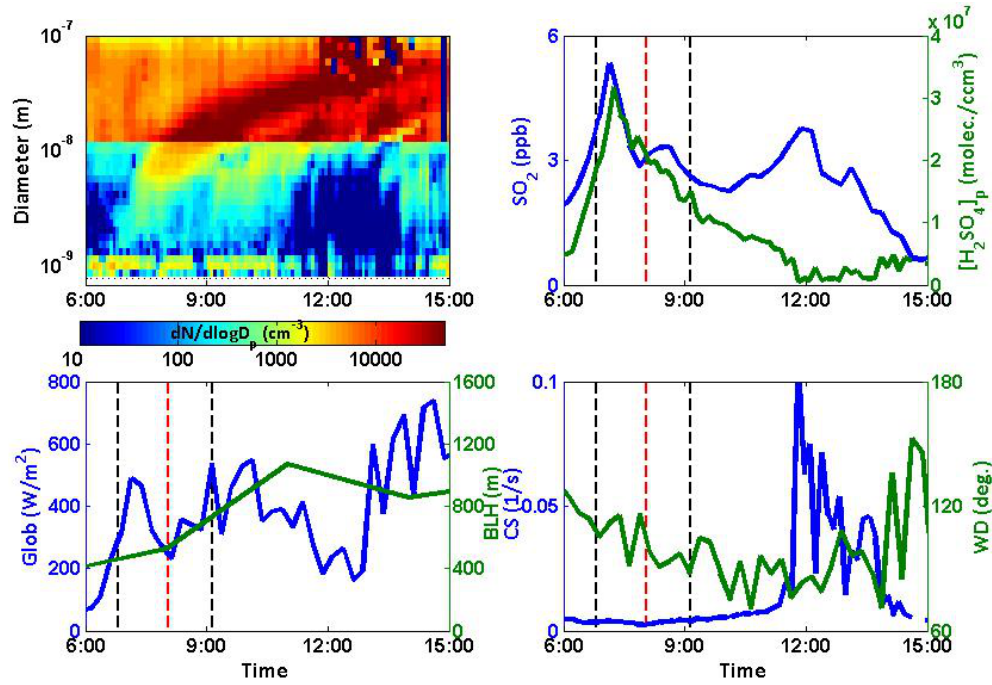
Fig. 1. Example of two consecutive nucleation and growth events (top left panel) at Marikana on 21 November 2009. The concentration of SO 2 and H 2 SO 4 -proxy (top right panel), values of CS and wind direction (bottom right panel), and boundary layer height and global radiation (bottom left panel) are also presented. The first black and red lines indicate the start and end of the first nucleation event, while the second vertical black line indicates the start of the second event. Data for ∂θ/∂z was unavailable for this day.